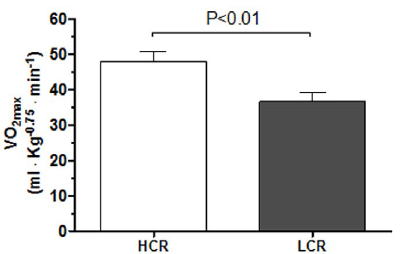
Figure 1. Aerobic capacity measured by maximal oxygen uptake (VO 2 max ) in Low Capacity Runner (LCR) and High Capacity Runner (HCR) rats. Data are presented as mean 6 SD.